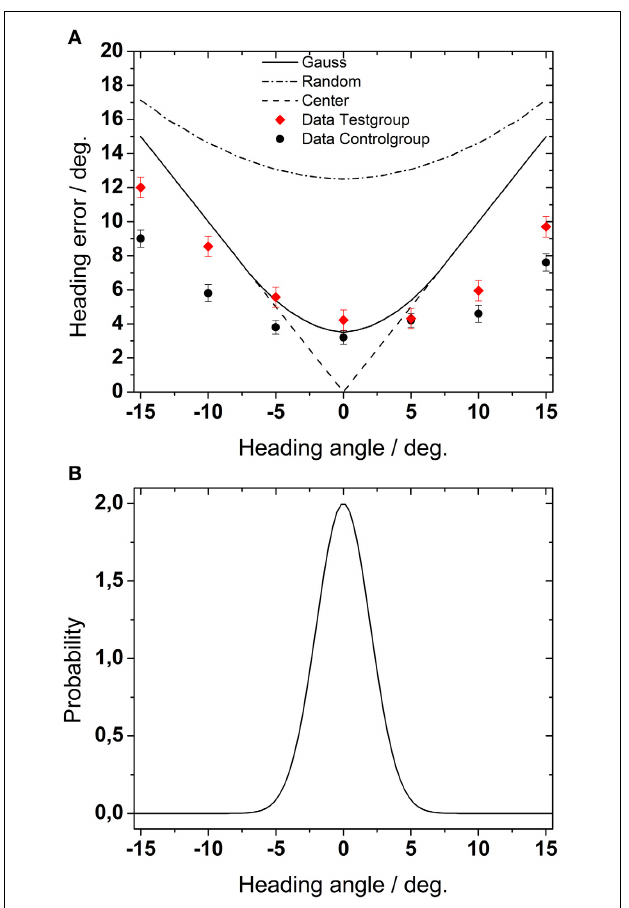
FIGURE 9 | (A) Estimation of maximum heading error. The dashed-dotted line shows the heading error for purely random behavioral performance, i.e., if heading values were randomly chosen with the same probability. The solid line represents simulated heading error if heading values were chosen according to a Gaussian probability function centered on straight-ahead [as shown in (B) , see text for details]. Finally, the dashed line represents simulated heading error for choosing always the center of the screen.